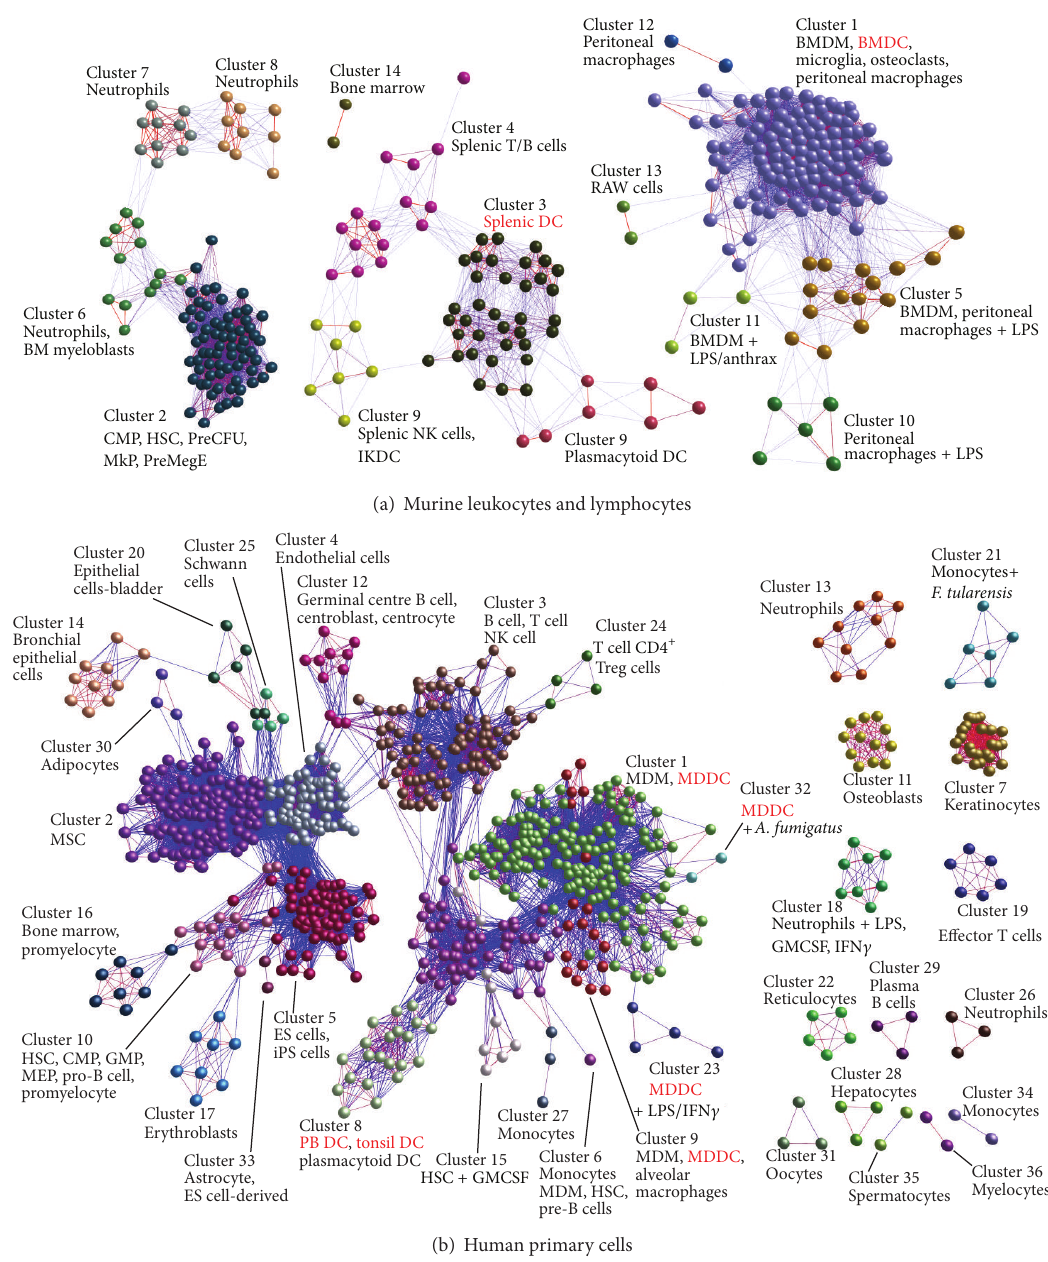
Figure 5: Transcriptional analyses show that mouse bone marrow-derived DC and human monocyte-derived DC are indistinguishable from macrophages. Clustering of cell subsets based upon their global gene expression profiles. In panels “(a)” and “(b)” Pearson correlation matrices were prepared by comparing the microarray data sets derived from all samples used in each study ([11] and [105], resp.). Graphs were then constructed using only those sample-to-sample relationships greater than 𝑟 = 0.9 and clustered with an MCL inflation value of 2.2. Each node represents an individual microarray data set and the edges are coloured on a sliding scale according to the strength of the correlation (red, 𝑟 = 1.0 ; blue, 𝑟 = 0.9 ). Each cluster of samples was assigned a different colour. Each of these analyses shows that at the transcriptomic level the in vitro bone marrow-derived DC (BMDC) or monocyte-derived DC (MDDC) prepared from mice (panel “(a)”) and humans (panel “(b)”) are indistinguishable from macrophages and do not cluster with conventional DC enriched from tissues such as the spleen, tonsils, or peripheral blood. The tissue DC, BMDC, and MDDC data sets are highlighted in red font. Reference [11] provides full details about the sources of all the 304 individual microarray data sets used in “(a).” Reference [105] provides full details about the sources of all the 745 microarray data sets used in “(b).” BMDC, bone marrow-derived dendritic cells; BMDM, bone marrow-derived macrophage; anthrax, Bacillus anthracis edema toxin; CMP, common myeloid progenitors; ES, embryonic stem cell; GMP, granulocyte monocyte progenitors; HSC, haematopoietic stem cell; IKDC, interferon-producing killer DC; MDDC, monocyte-derived DC; MDM, monocyte-derived macrophage; MEP, megakaryocyte-erythroid progenitor cell; MkP, megakaryocyte progenitors; MSC, mesenchymal stem cells; NK, natural killer; PreCFU- E, preerythroid progenitors; PreMegE, premegakaryocyte/erythroid; PB, peripheral blood; Treg, regulatory T cell. Panel “(a)” is reproduced from [11] with permission from Elsevier. Panel “(b)” is reproduced from [105] under the terms of the Creative Commons Attribution License